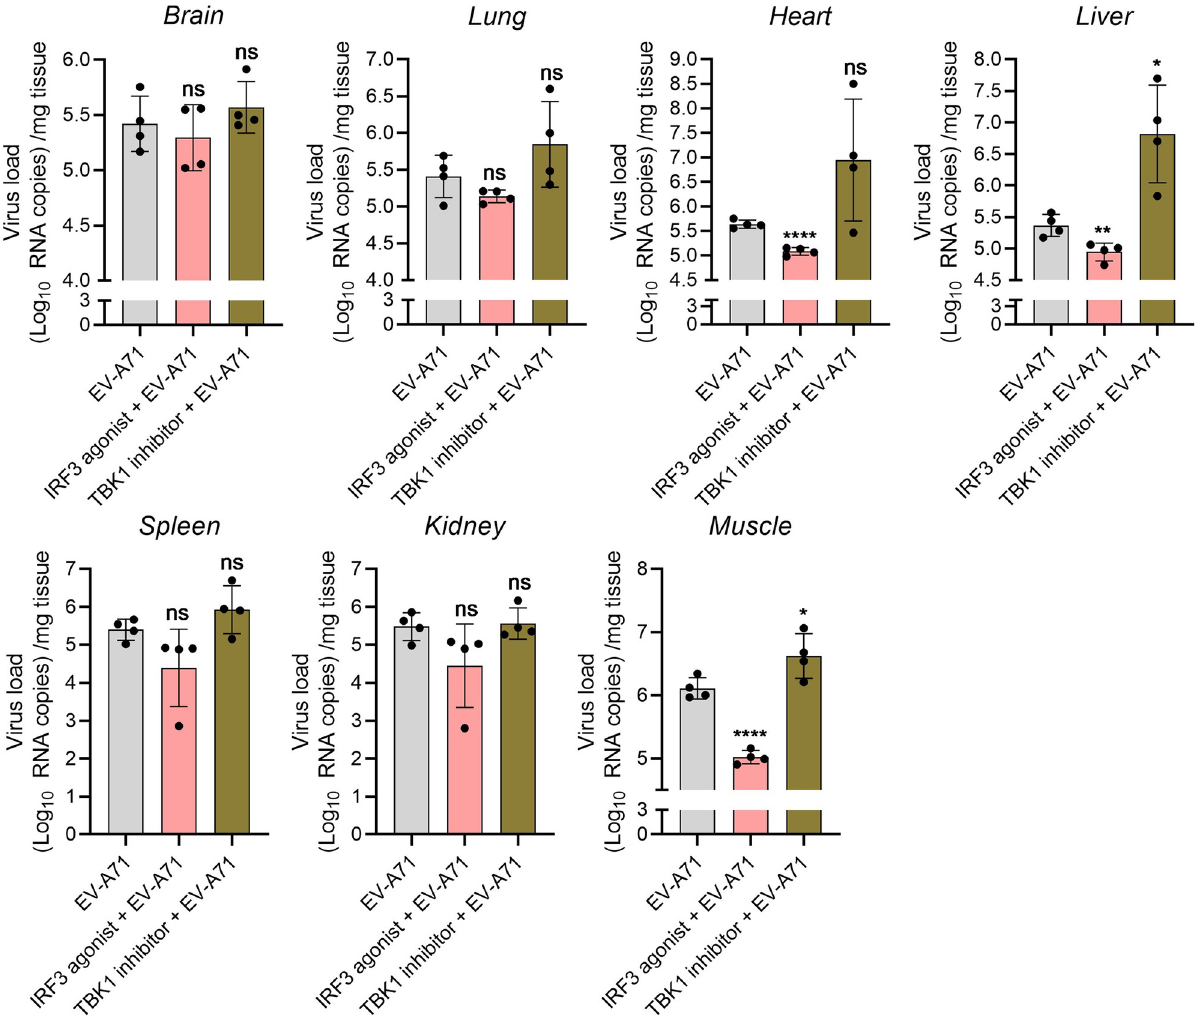
Fig 4. TBK1 and IRF3 interventions on EV-A71 replication. Viral loads in the brains, lungs, hearts, livers, kidneys, spleens and skeletal muscles of mice at 5 dpi were determined by qPCR. Results were expressed as Log 10 RNA copies/mg tissue. n = 4 per group; TBK1 and IRF3 interventions in mice with EV-A71 infection vs EV-A71-infected mice; � P < 0.05; �� P < 0.01; ���� P < 0.0001; ns, no significant. All the experiments were repeated at least three times.